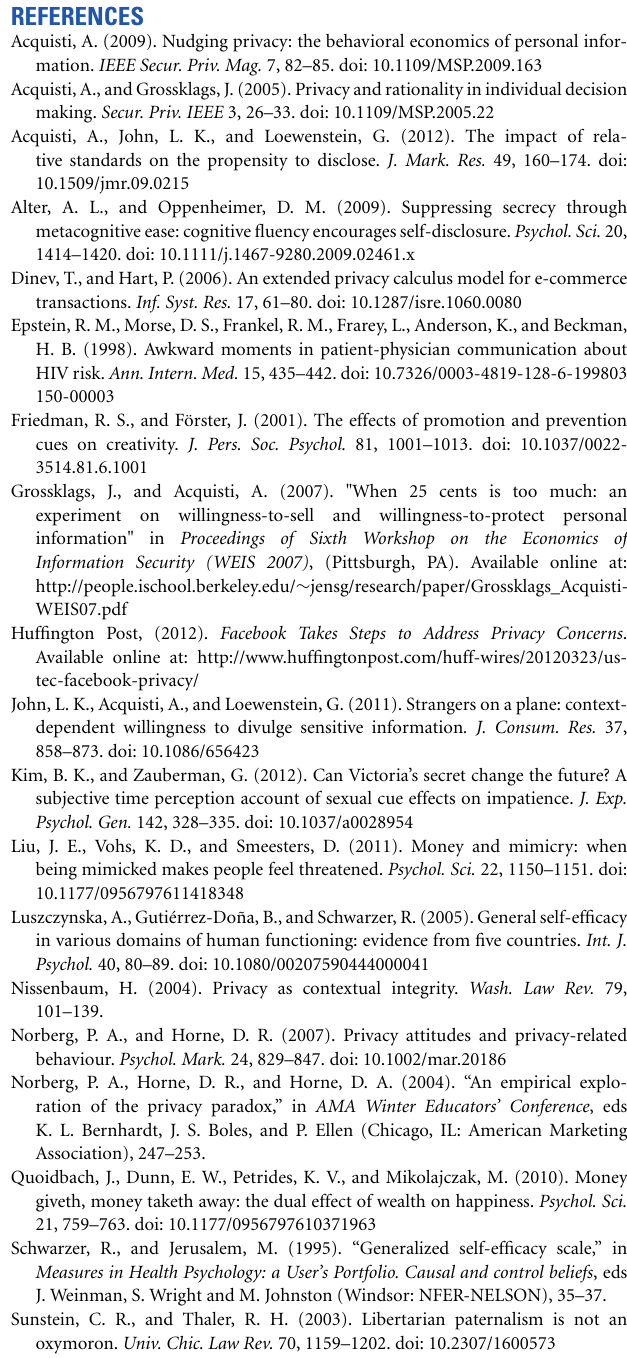
Figure S1 | Form for money group in experiment 1. Figure S2 | Form for control group in experiment 1. Table S1 | Mean willingness to disclose in Experiment 1. Table S2 | Number of participants who disclosed the following information in experiment 2. Table S3 | Results of the One-Way ANOVA for experiment 1 (mean privacy-disclosure index) and Experiment 2 (actual disclosure and